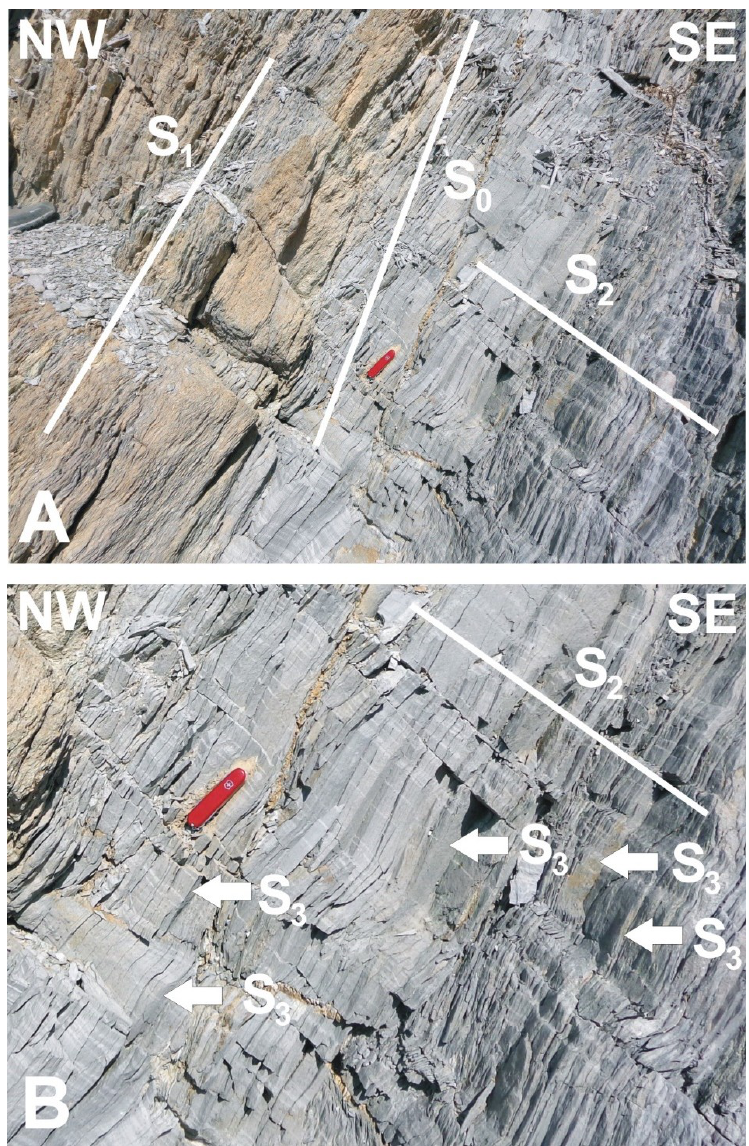
Figure 9. S 0 and cleavage sets in Am 1. The outcrop shows two lithologies. In the upper left area is beige sandstone, and the rest is gray siltstone. Red pocket knife for scale is in the same position in both photographs. ( A ) Closely spaced S 1 cleavage with little orientational scatter. The orientation of S 1 is subparallel to S 0 (bedding). S 1 is more widely spaced in quartzites (Figure 8B). S 2 is more widely spaced than S 1 with some orientational scatter. ( B ) Detail of Figure 9A, showing S 2 and S 3 . S 3 is indicated by white arrows whose heads are pointing to individual S 3 surfaces.